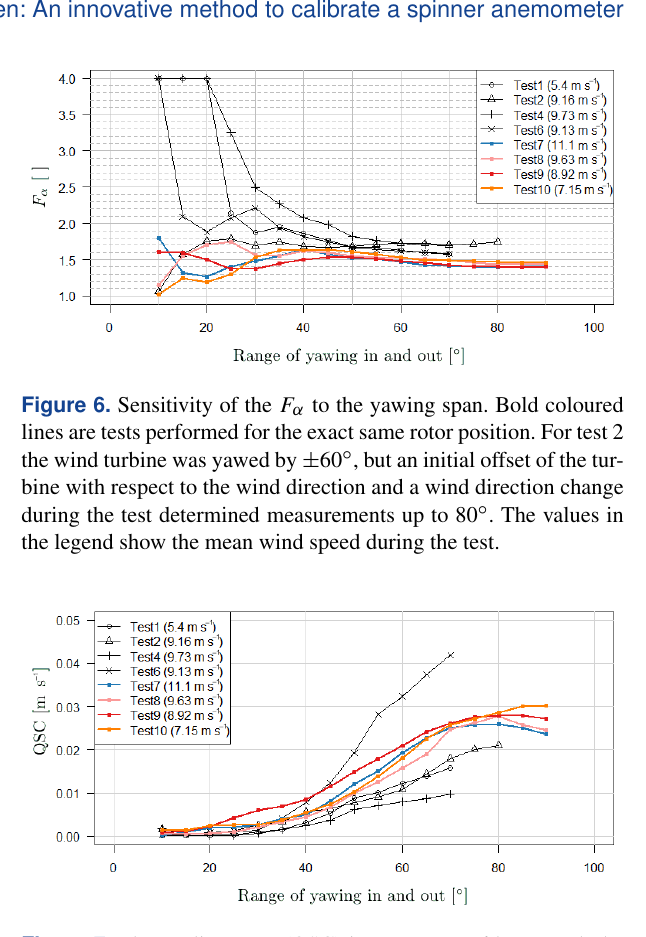
Figure 7. The quality score (QSC) is a measure of how much the RMSE as a function of F α peaks at the minimum. A wide yawing span gives a clearer peak. The values in the legend show the mean wind speed during the